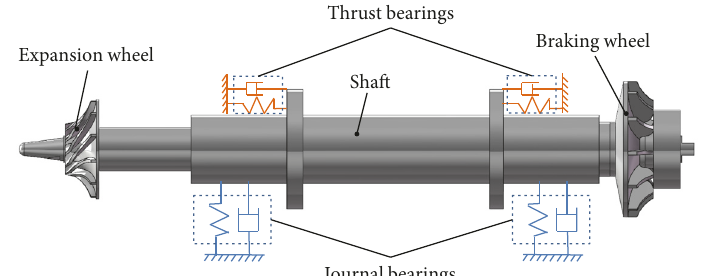
Figure 2: Rotor-bearing system of the turboexpander.